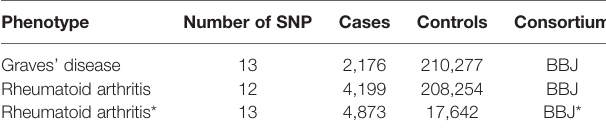
TABLE 1 | Descriptive details of the source of Graves ’ disease and rheumatoid